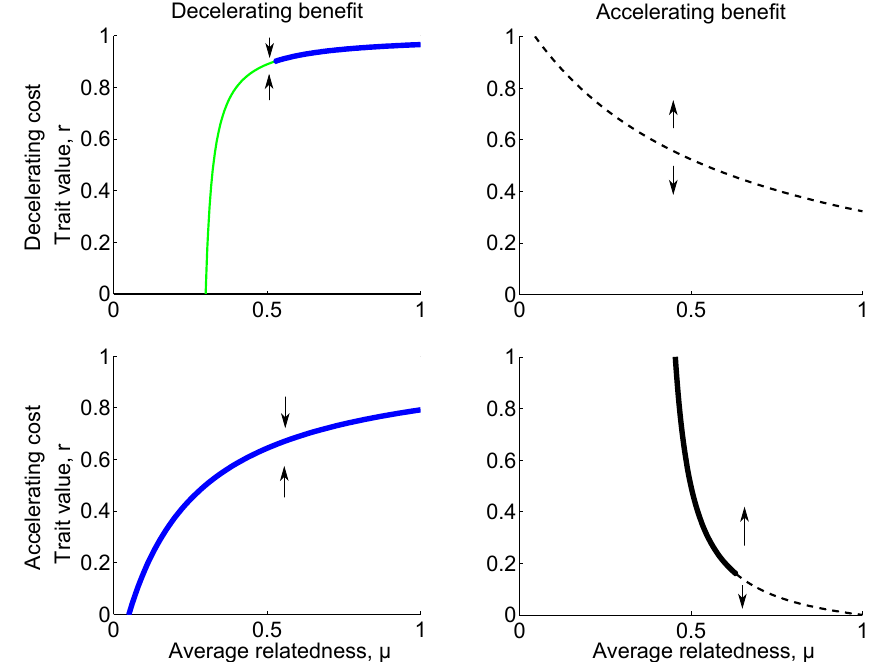
Figure 2. Bifurcation diagrams showing how the evolutionary dynamics depend on average relatedness for all four possible combinations of the accelerating and decelerating benefit and cost functions in Figure 1. Green thin line represents convergence stability without evolutionary stability, blue thick line represents convergence stability with evolutionary stability, black dotted line represents neither convergence stability nor evolutionary stability, and black thick line represents evolutionary stability without convergence stability. We see that the four cases are qualitatively different. We also see that, when B and C are both decelerating, a certain range of relatedness leads to evolutionary branching. The parameters used were in all cases N = 10, and b 1 , b 2 , c 1 , c 2 as in Figure